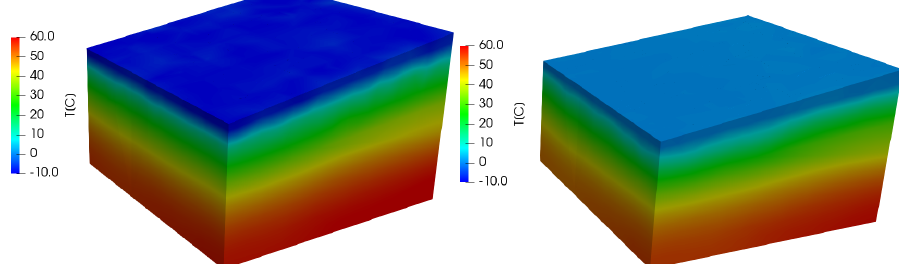
Figure 15. Comparison of the initial ( t = 26 ky on the left) and final ( t = 0 ky on the right) temperature − fields. It is observed, at the depth of 4 km, temperature gradient of approximately 60 ◦ C as qualitatively expected in